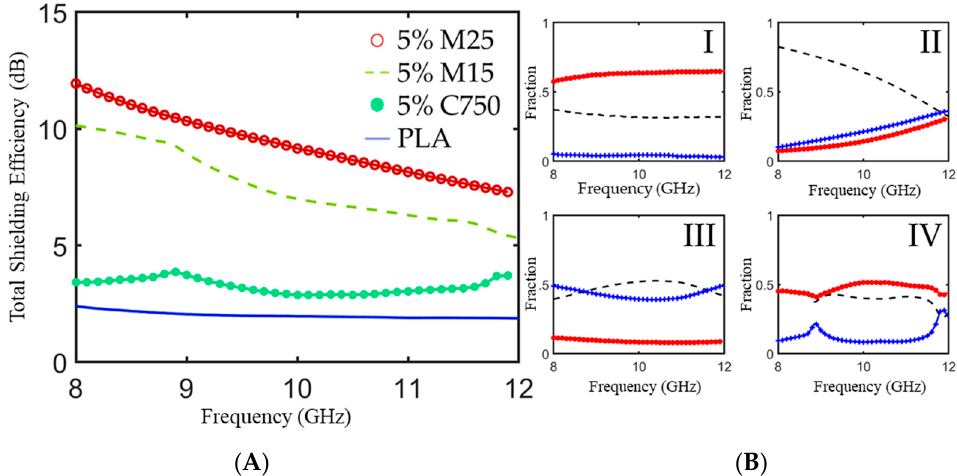
Figure 5. ( A ) Total shielding efficiency as measured in an X-band waveguide for xGNP/PLA composite plaques fabricated with different aspect ratio starting material. ( B ) Power balance for 5 wt % xGNP/PLA composite plaques loaded with (I) neat PLA, (II) M25, (III) M15, and (IV) C750. All plaques have a thickness of 3 mm.